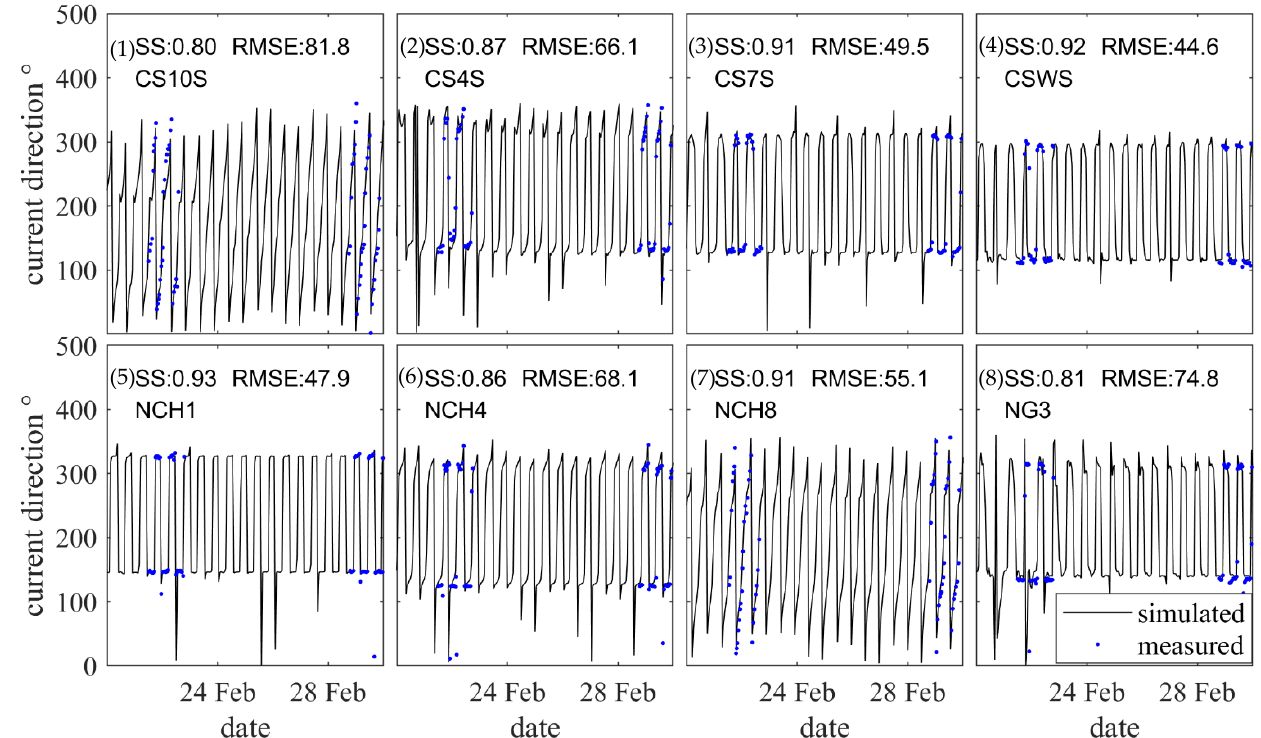
Figure 8. Model validation results for current direction. (1)–(8), measured (blue dots) and simulated (black line) results at CS10S, CS4S, CS7S, CSWS, NCH1, NCH4, NCH8, and NG3, respectively.